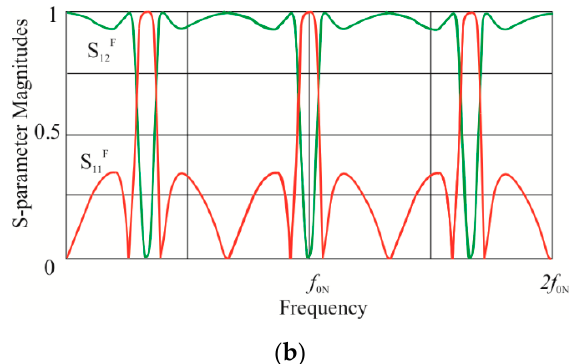
Figure 3. S-parameter magnitudes of the proposed bandstop filter on the base of its TEM model: ( a ) for the frequency band from 0 up to the reference frequency, ( b ) through band 0–double reference frequency.